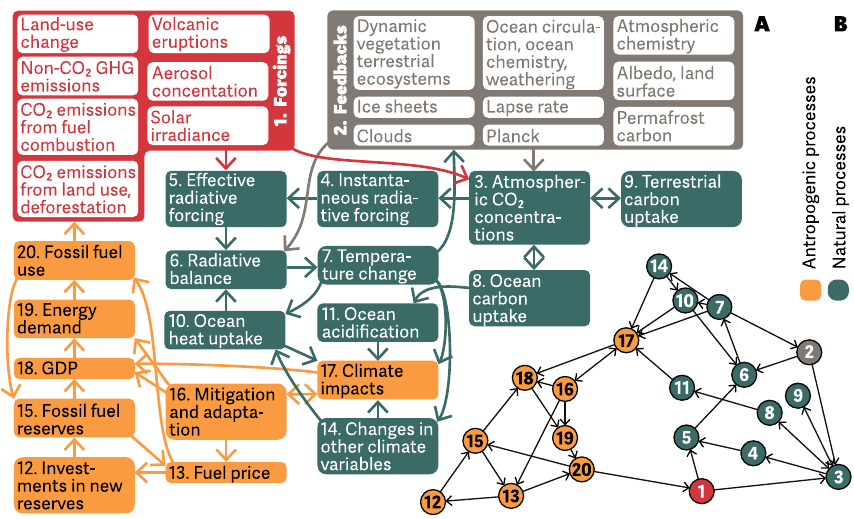
Fig. 2 The causal structure of a climate model. The network in panel A , adapted from (Knutti and Rugenstein 2015), illustrates some components and their interdependencies in a typical large-scale climate simulation model. In panel B , we show the same network as a directed graph where we keep the color coding of the initial